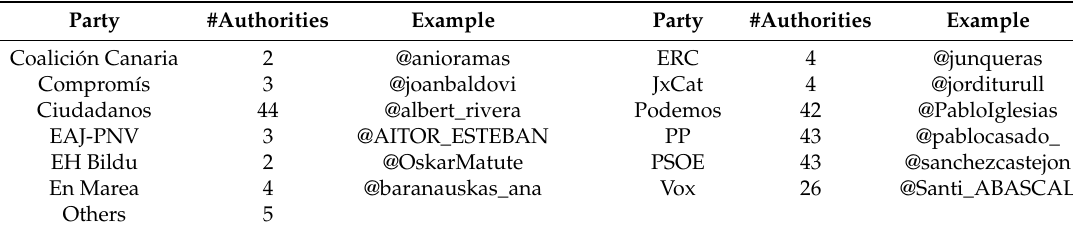
Table 1. Distribution of authorities among